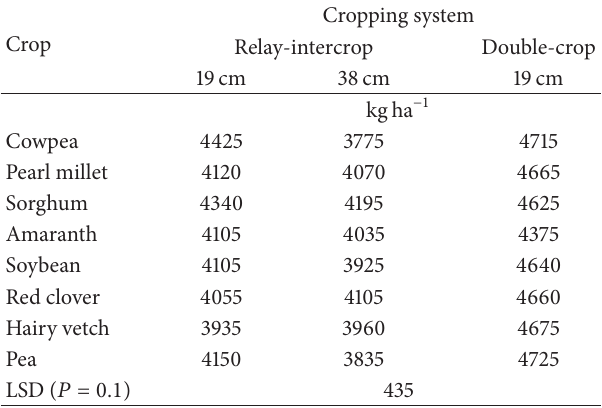
Table 2: Wheat yield response averaged across years to relay- intercrops planted into 19 and 38 cm row spacings and following 19 cm wheat with no mechanical damage that was subsequently double-crop seeded in 2012 and